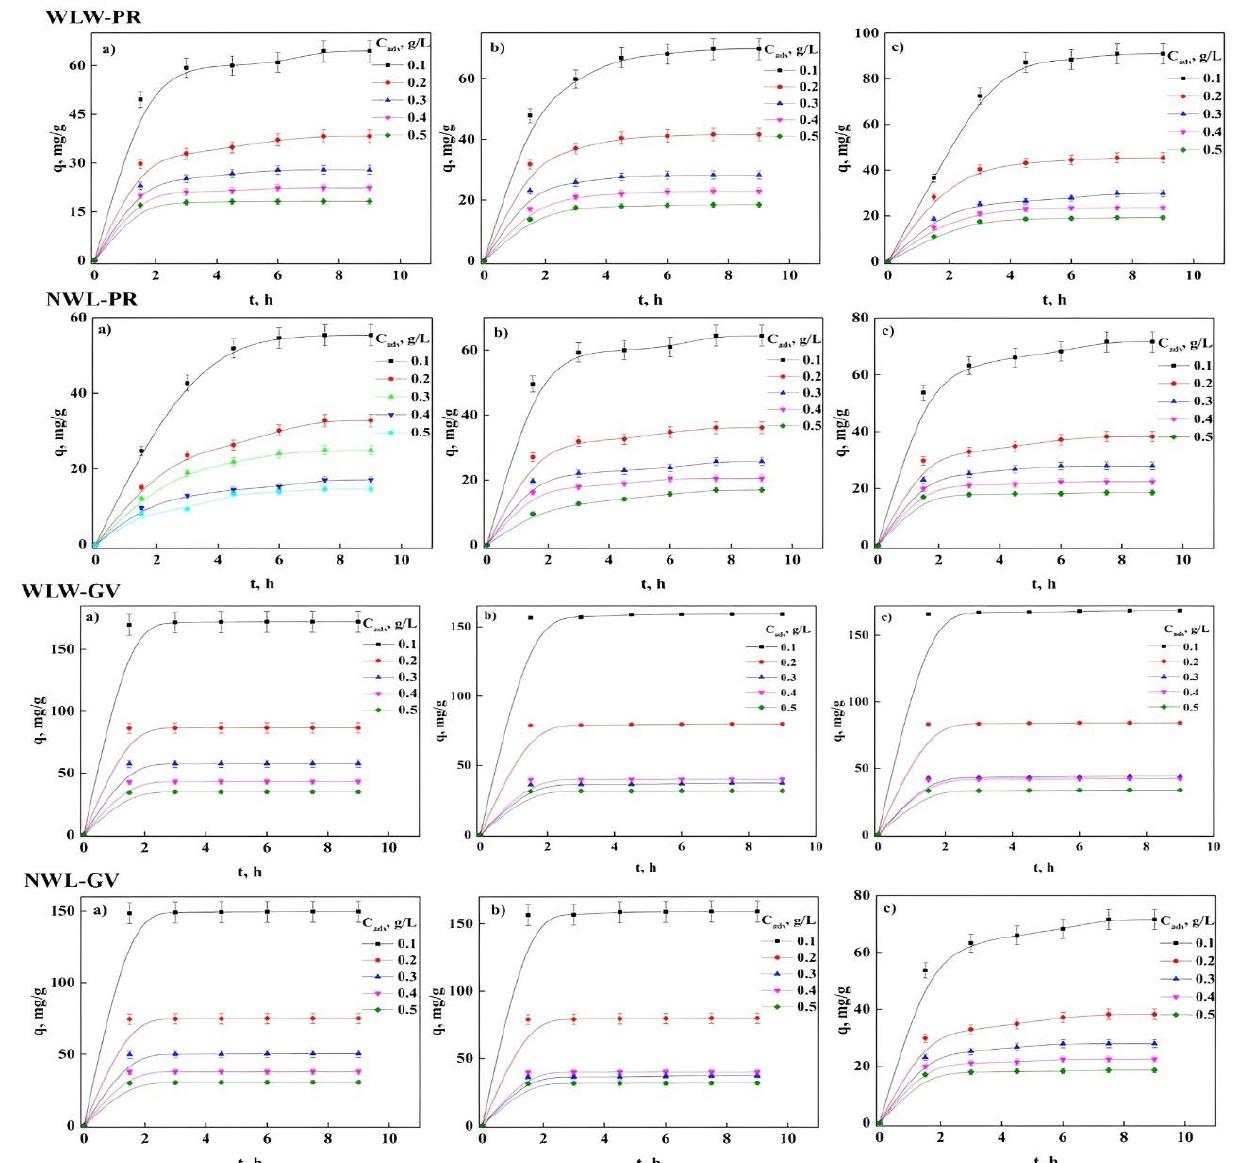
Figure 5. Contact time of the adsorption process of PR and GV in WL: ( a ) 30, ( b ) 45, and ( c ) 60 °C.